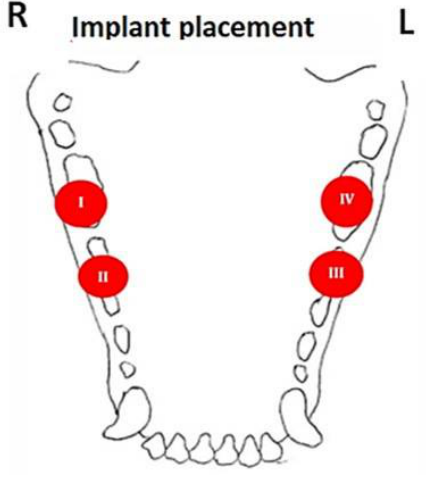
Figure 4. Schematic description of implant placement sites.